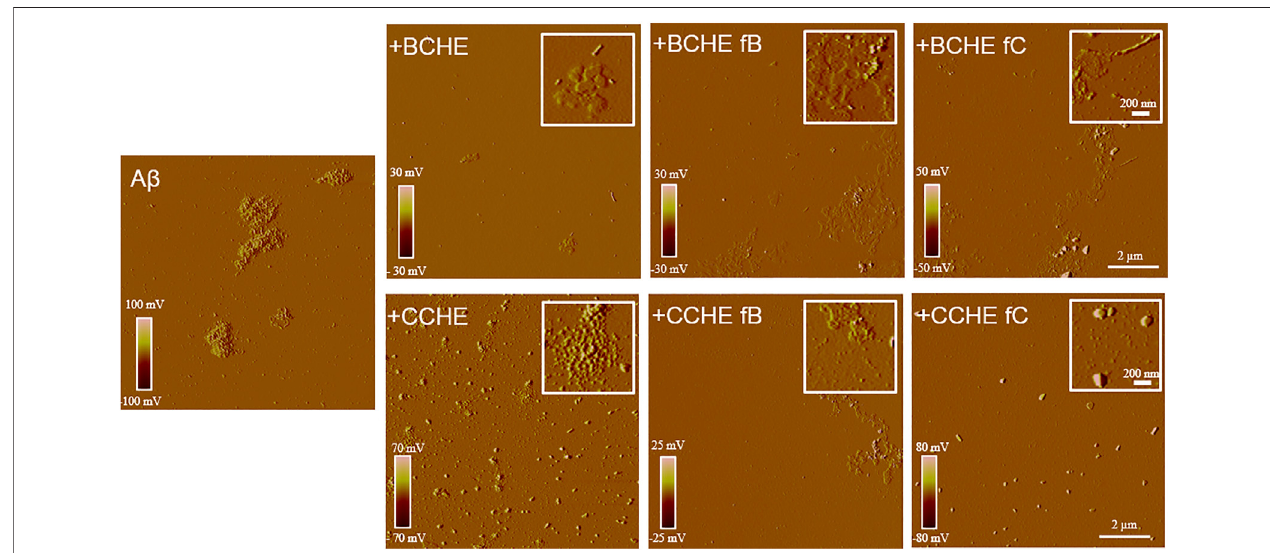
FIGURE 4 | Effects of cinnamon extracts and fractions on A β 1-42 aggregates ’ morphology. AFM images were acquired after 24 h incubation at 37 ° C of A β 1 – 42 peptide (2.5 μ M) with or without cinnamon extracts BCHE and CCHE and related fractions B and C (2.5 µg/ml). BC: Cinnamomum cassia buds; CC: Cinnamomum cassia bark; E: alcoholic extraction in ethanol; HE: hydroalcoholic extraction in water (pH 4.5)/ethanol 7:3; fB: fraction B; fC: fraction